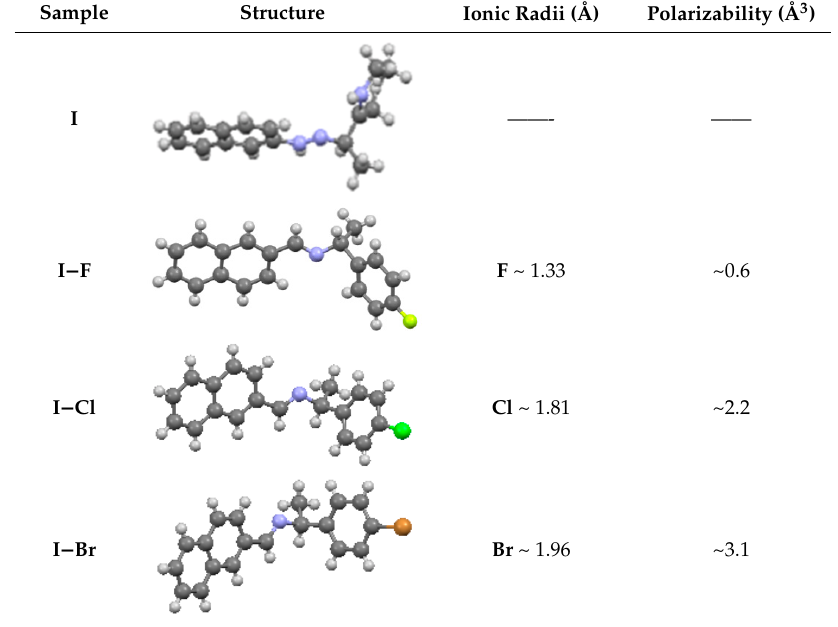
Table 2. Selected crystallographic data of the chiral imines.